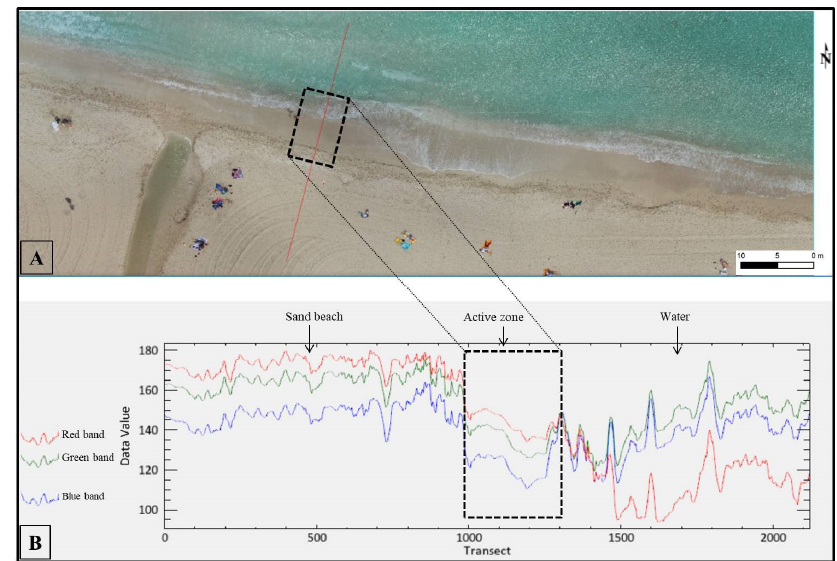
Figure 4. Reflectance thresholding on unmanned aerial vehicle (UAV) orthomosaic image. The very high-resolution three-band—red, green, blue—image (A), indicating areas occupied by a sand beach, active zone (high and low water level), and water. The analysis of reflectance data pixels for each band revealed changes in data values, especially in a red band with high, relatively low, and low values for the sand beach, active zone, and water, respectively. Table 4. Masking out GeoEye-1 NIR and UAV orthomosaic red band based on threshold reflectance values.